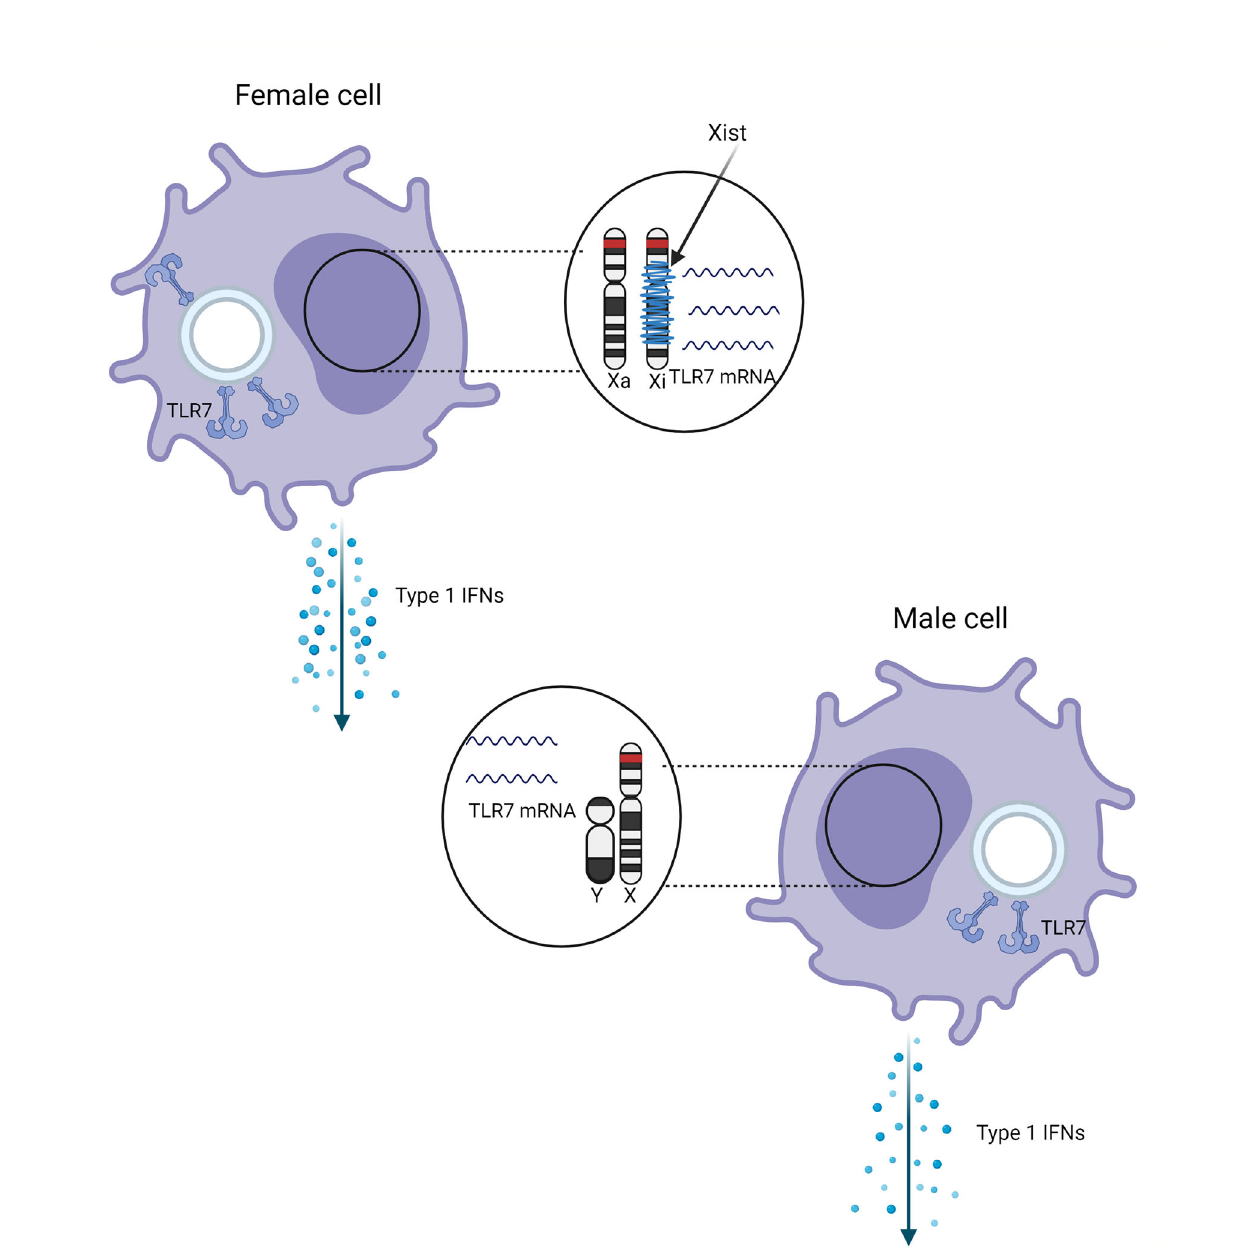
FIGURE 1 | Schematic representation of the effect of sex and X chromosome inactivation escape on the TLR7 expression. TLR7 gene (red) on the inactivated X chromosome (Xi) wrapped with Xist (blue) escapes inactivation. Escape from distal X chromosome inactivation in female pDCs may result in more TLR7 mRNA and protein compared male cells, resulting in higher production of type 1